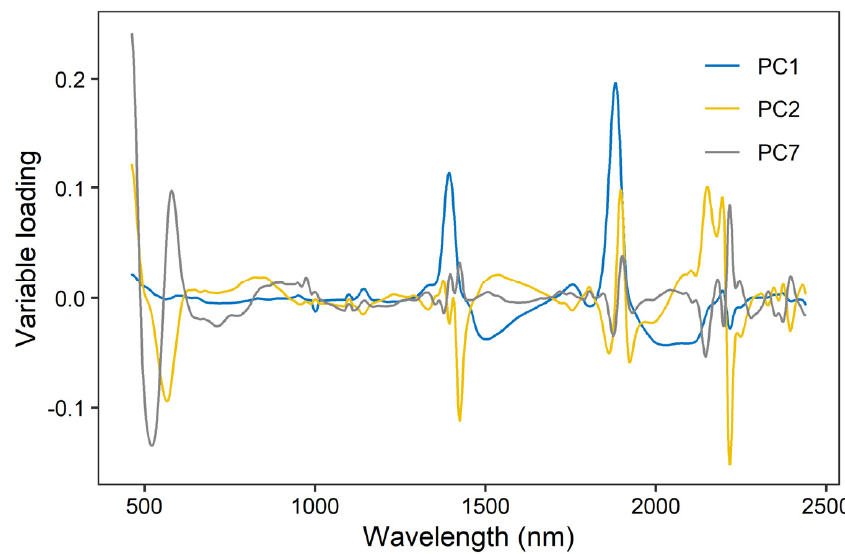
Figure 7. Variable loading of the three most important principal components (accounting for 85% of total variance) in XGBoost model (PC1, PC2, and PC7).